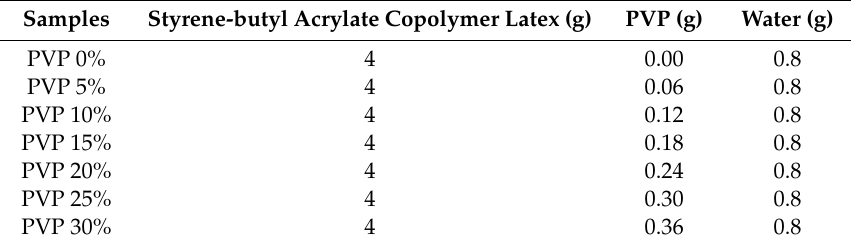
Table 1. The detailed formula of emulsion.